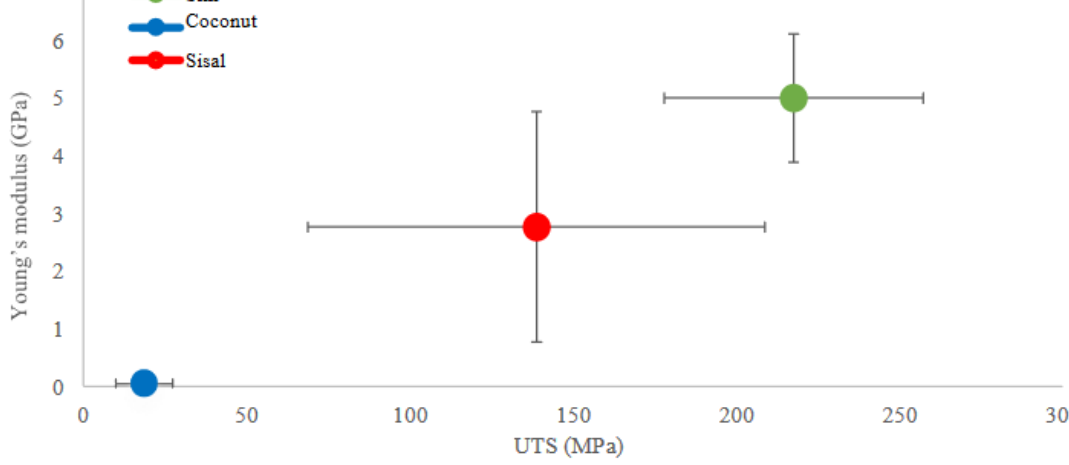
Figure 5. Comparison of UTS (MPa) and Young’s modulus (GPa) of silk fibers with average of coconut and sisal fibers. In the graph, sisal fibers are closer to the mechanical properties of silk control, compared to coconut fibers, they do not represent an approximation to the expected properties.